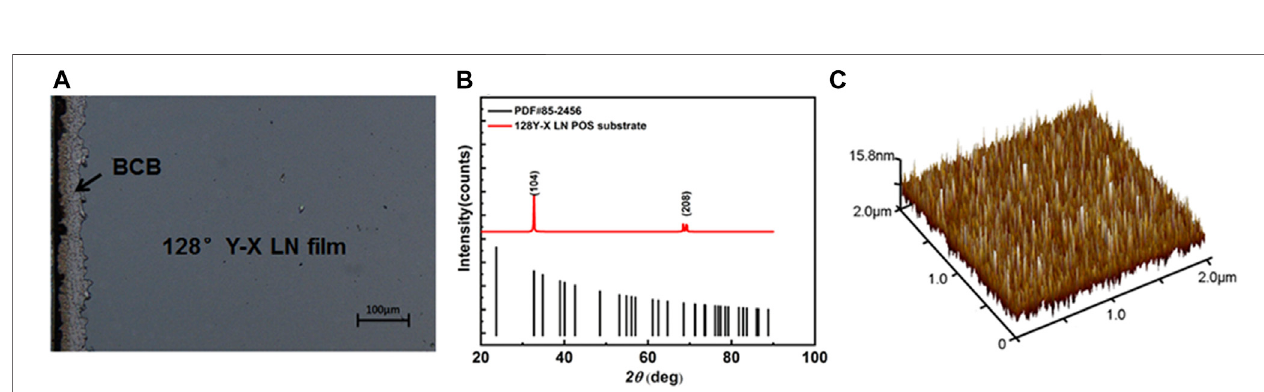
FIGURE7|(A) theopticalmicroscopyimagesofthe128 ° Y – X LNPOSsubstratesurface, (B) theXRDspectrumofthestrippedLNthin fi lmonthe128 ° Y – X LNPOS substrate, and (C) AFM images of the 128 ° Y – X LN POS substrate surface.